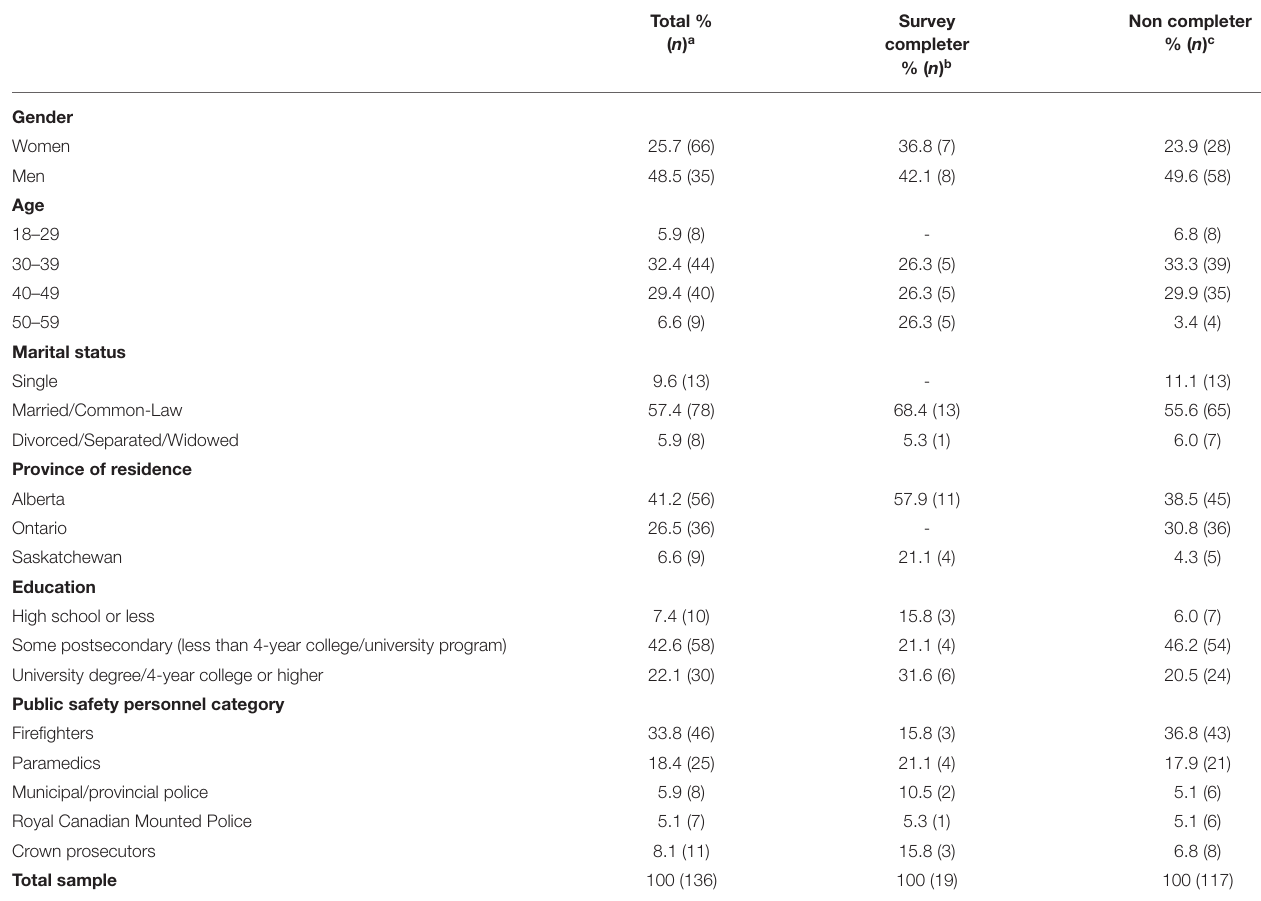
TABLE 1 | Public safety personnel